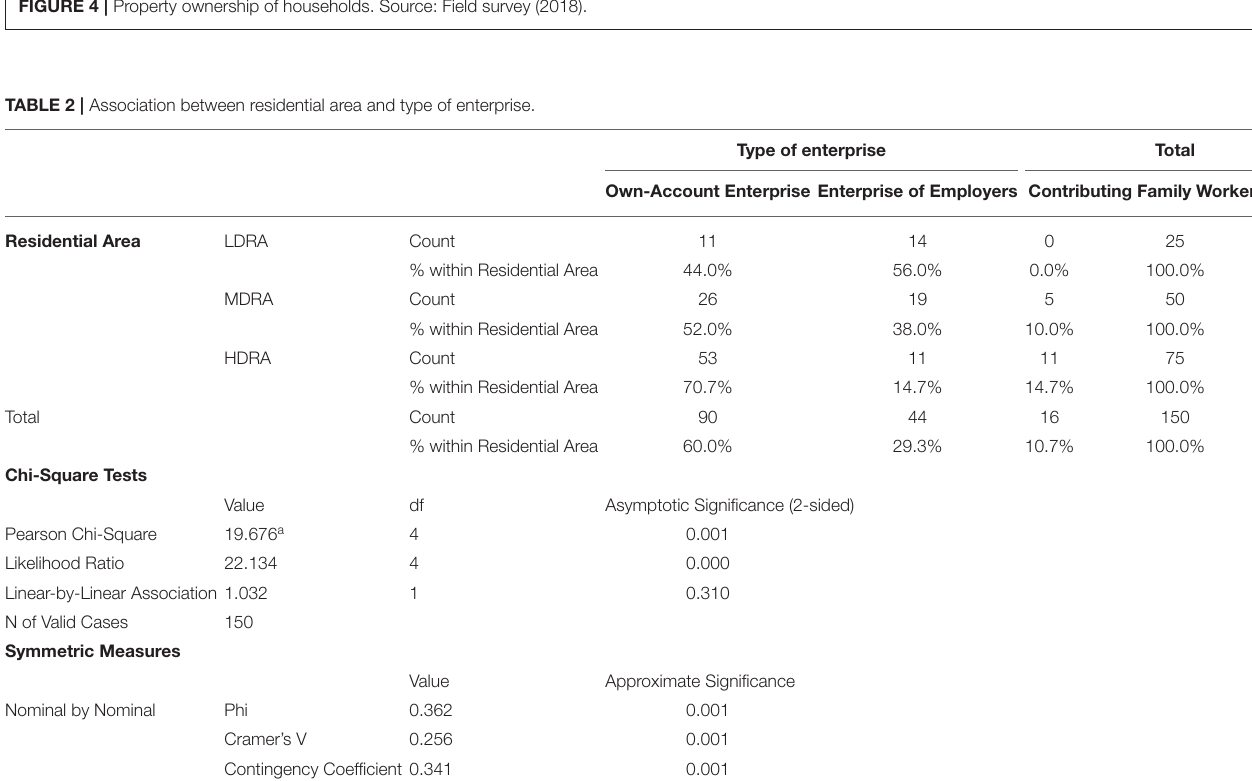
FIGURE 4 | Property ownership of households. Source: Field survey (2018).